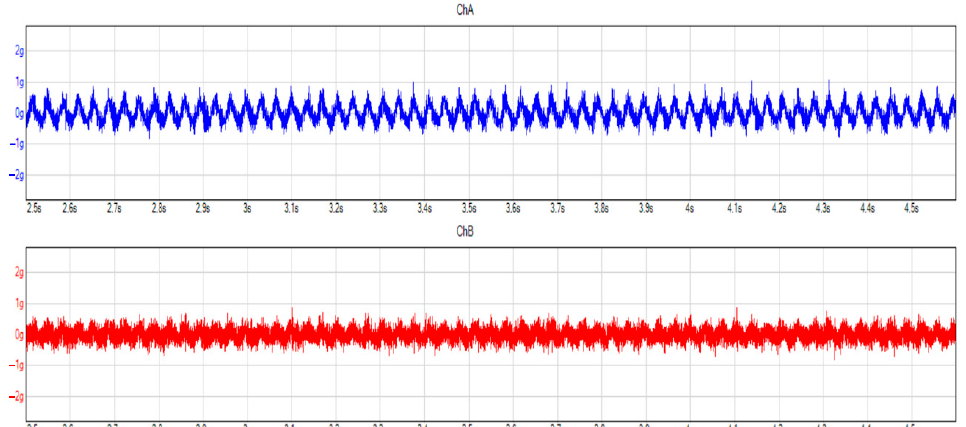
Figure 6. Measurements on the transmission after oil change in the time domain. Blue and red colors mean the different considered and applied channels, during the measurement.